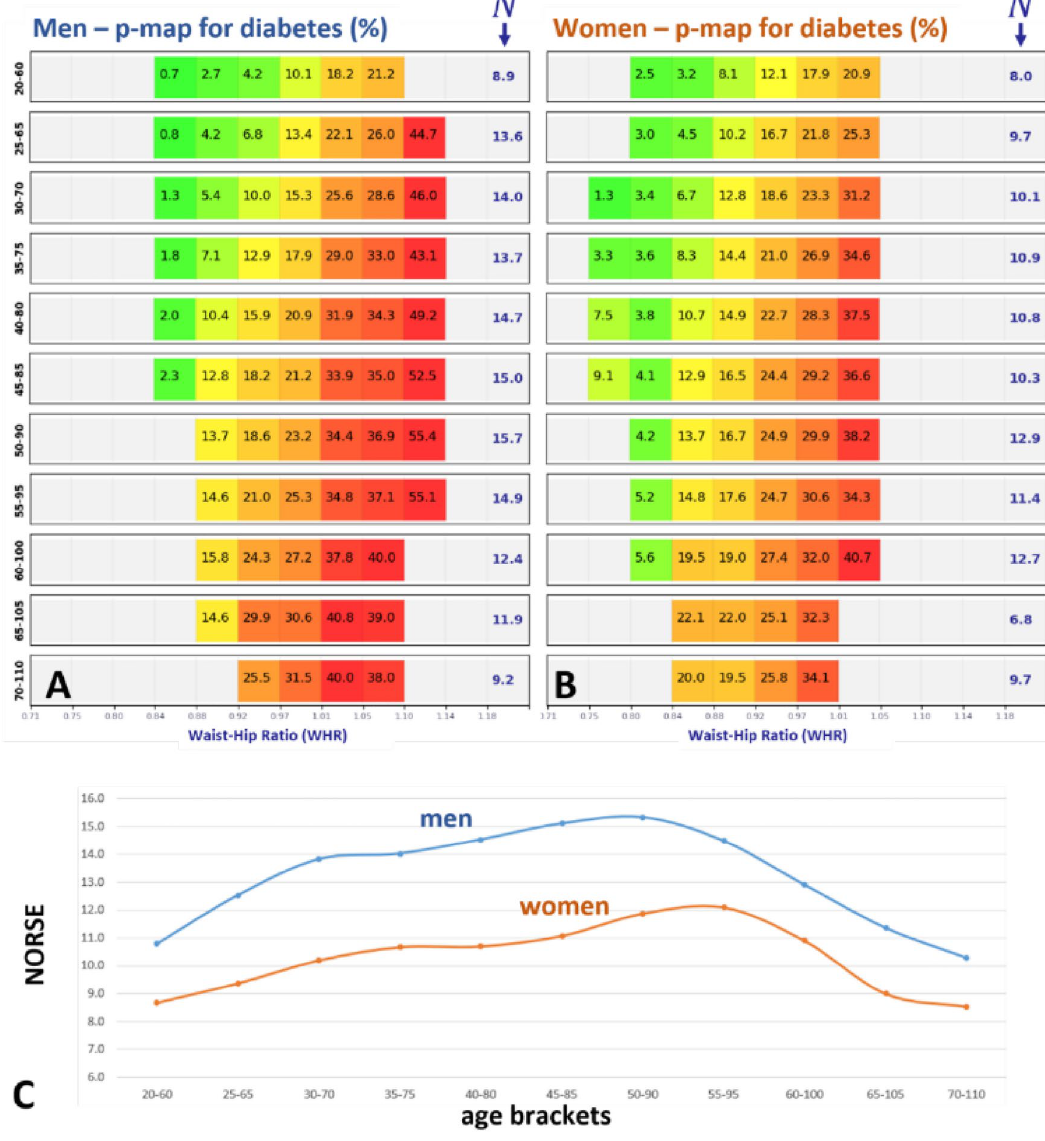
and leg length have slightly negative NORSE scores, suggesting that tall people with long legs are statistically associated with lower health risks. Interestingly, the top performing biomarkers are all regional ones; specifically, measurements associated with abdominal fat (e.g., WHR, ABSI, RFM, PTF). In the middle of the table we have global composition biomarkers (e.g. PBF, FMI, BMI); and at the bottom, biomarkers that do not correlate much with body composition (e.g., standing height, leg length). NORSE scores were able to cluster all biomarkers into these three groups automati- cally. Note that PBF is the strongest of the global adiposity biomarkers. The bottom row in the table reports column-wise average NORSE scores. Their value indicates which health conditions are “easier” to predict from individual biomarkers. In our results, hypertension shows the largest average NORSE, and cancer the lowest. Age stratification analysis. As an example, the tables in Fig. 2 show diabetes prevalence with respect to WHR, for men and women and for different age brackets. As age increases diabetes prevalence increases, on average. The NORSE values follow a curve; they are low for young and elderly people, and they are higher in the middle. Very young people tend to have low diabetes risk even for high WHR values, and older people tend to have high prevalence, independent of WHR. People in the middle are those where changing WHR may have the greatest influence on their diabetes risk.